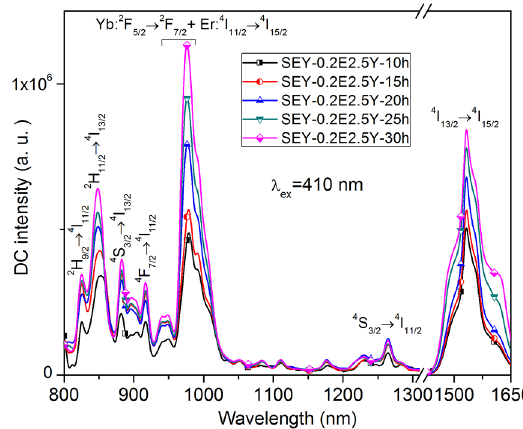
Figure 6. DC emission spectra of SEY-0.2E2.5Y-10h, SEY-0.2E2.5Y- 15h, SEY-0.2E2.5Y-20h, SEY-0.2E2.5Y-25h, and SEY-0.2E2.5Y-30h transparent glass-ceramics